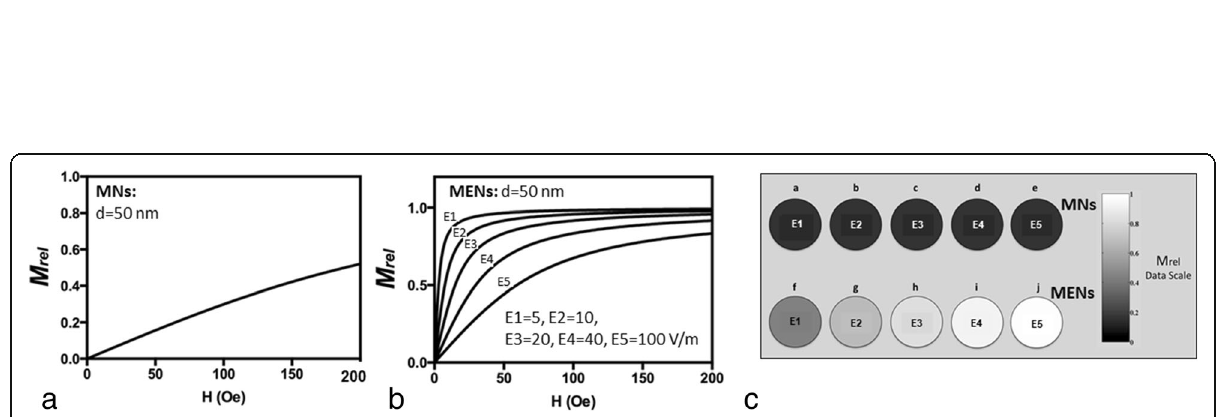
Fig. 2 Magnetic field response of MNs and MENs depending on the nanoparticle size and local electric field at the micron-size scale. a M rel (H) for MNs. ( b ) M rel (H) for MENs for five different values of the local electric field: E1 = 5, E2 = 10, E3 = 20, E4 = 40, E5 = 100 V/m. The relative magnetization is the ratio of the magnetization and its saturated